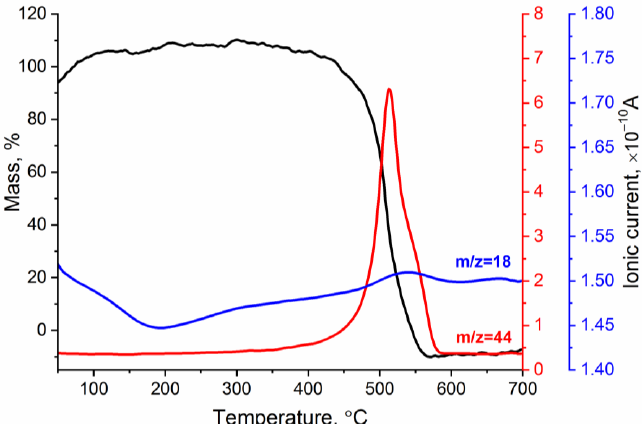
Figure 5. TG curve and temperature dependencies of ionic currents corresponding to H 2 O ( m / z = 18) and CO 2 ( m / z = 44) during rGO fragmentation and oxidation.